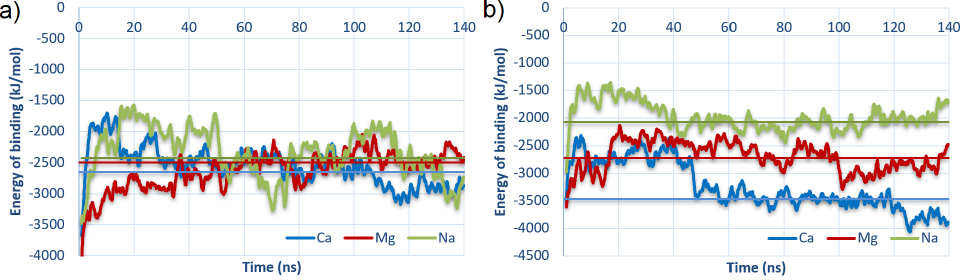
Figure 7. Energy of binding as a function of time for the strongest bound complexes: ( a ) #2 for HSA:CS-6; and ( b ) #3 for HSA:CS-4 (cf., Table 1). The vertical lines represent the average over the last 100 ns of